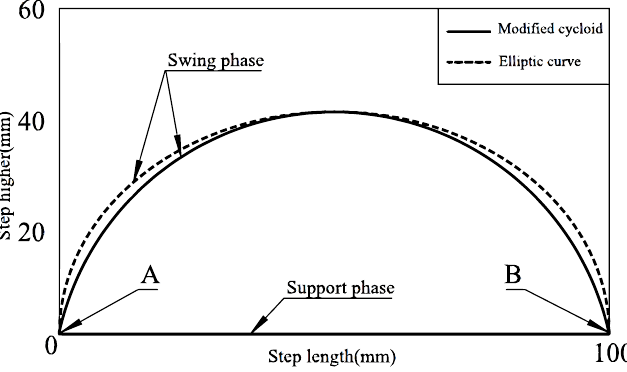
Figure 5. Correction of cycloid and elliptic curves.